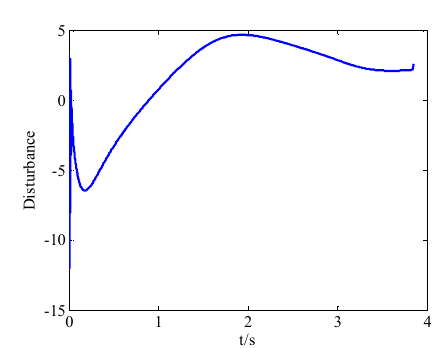
Figure 9. Proposed method.